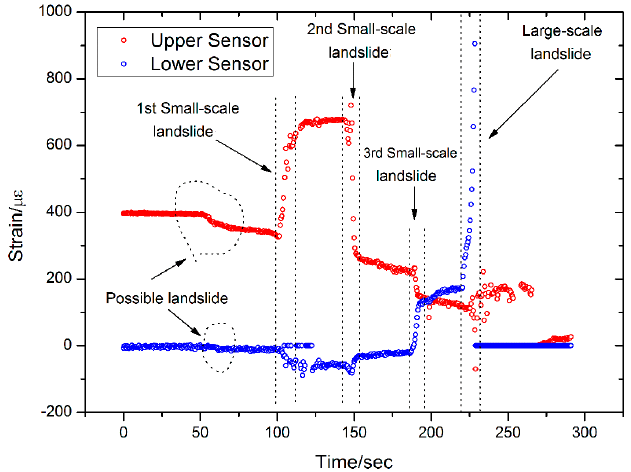
Figure 17. Results from Sensor 4.